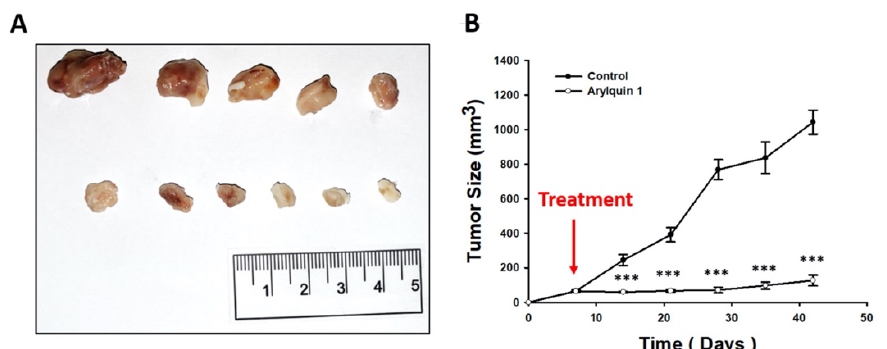
Figure 8. ( A ) Gross examination and ( B ) tumor growth curves of mouse xenografts of human colo- rectal cancer with and without Arylquin 1 treatment; quantitative data are expressed as mean ± SEM; *** p < 0.001 compared to the control group.